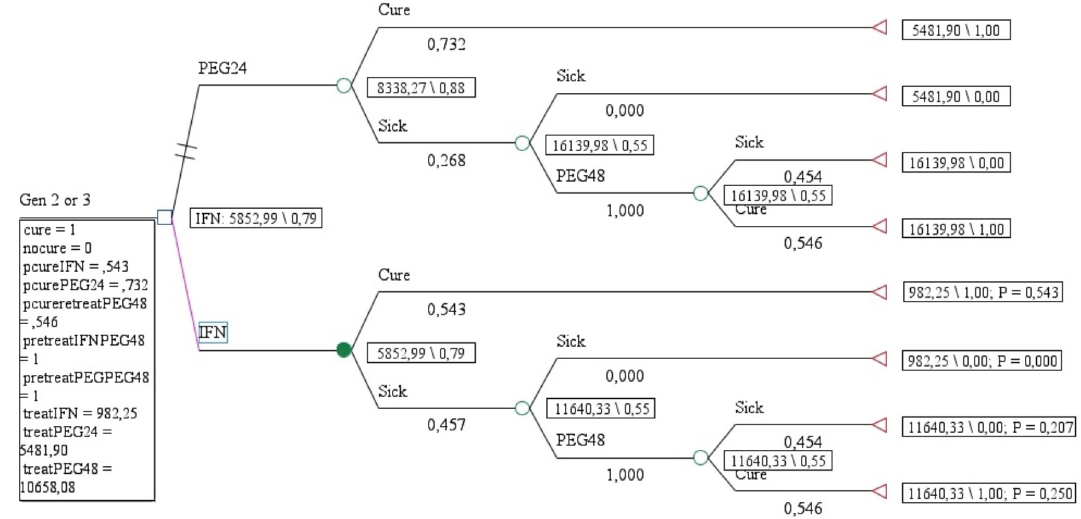
FIGURE 2 - Results of cost effectiveness analysis comparing PEG-SEC with